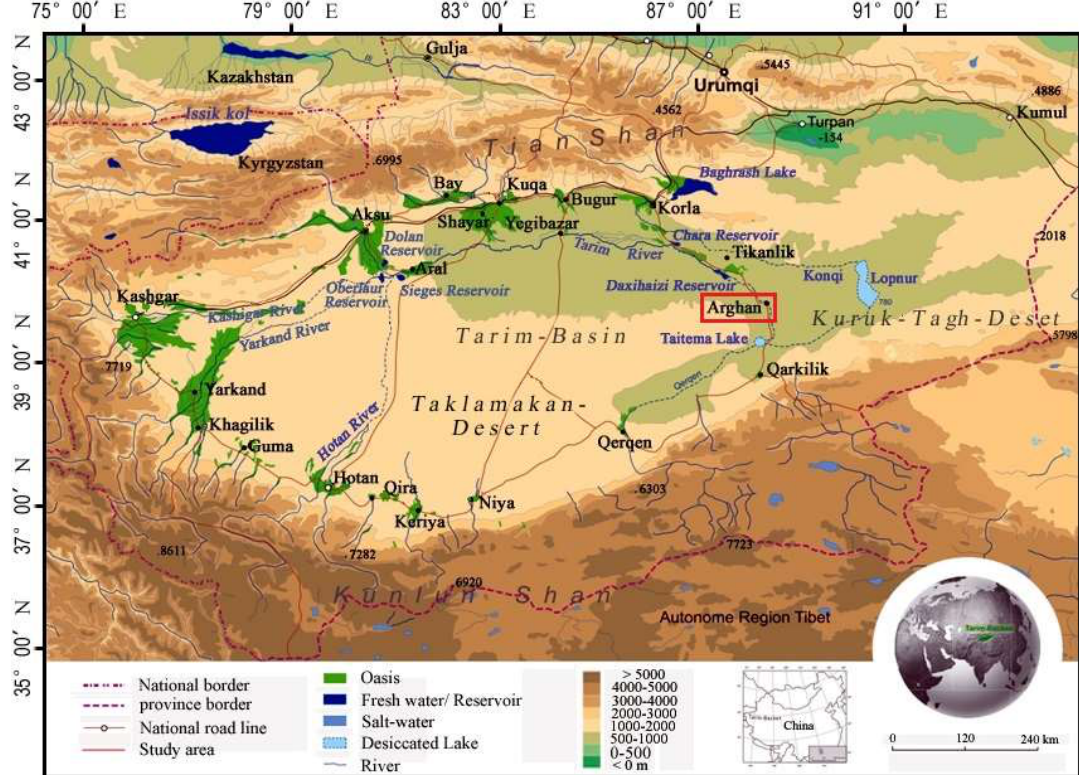
Figure 1. Locations of the lower reaches of the Tarim River and the Arghan transects.